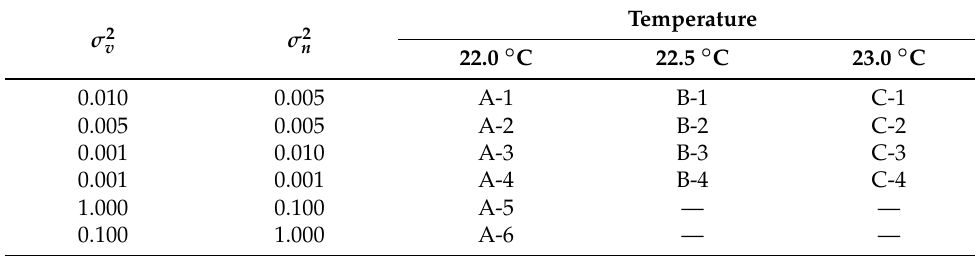
Table A1. Details of the tests performed ( N p = 1000).